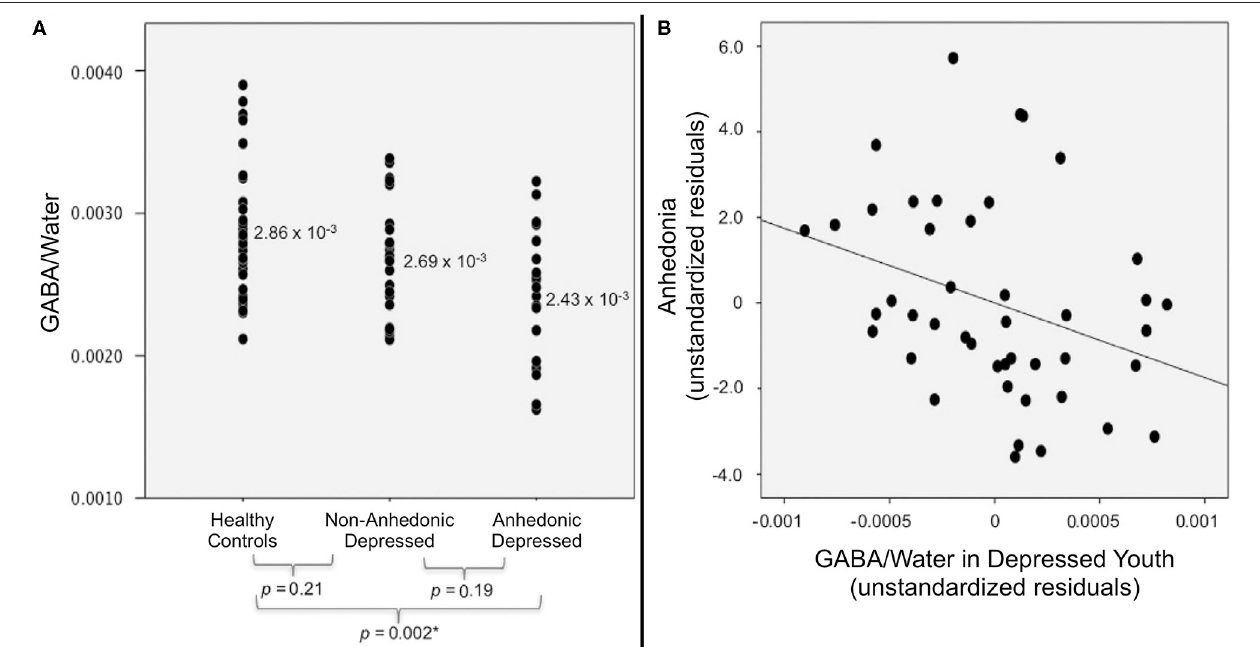
FIGURE 10 | Relationship between anhedonia and ACC GABA levels in adolescents, measured by 1 H MRS (standardized vs. water peak). (A) When depressed subjects were stratified into anhedonic ( n = 19) and non-anhedonic ( n = 25) subgroups, only anhedonic subjects differed significantly from healthy controls ( n = 36). (B) Within the combined sample of depressed adolescents ( N = 44), anhedonia was negatively associated with ACC GABA after controlling for depression severity (partial r = − 0.33, p = 0.03). Excerpted from (170). * Significant at the Šidák-corrected p < 0.05